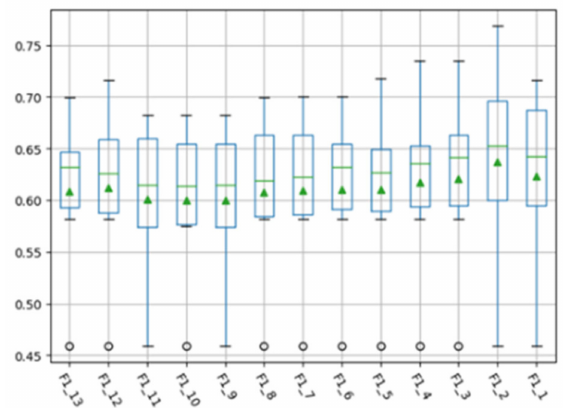
Figure 2. F1 values obtained from different subspace dimensions on the Relink dataset.